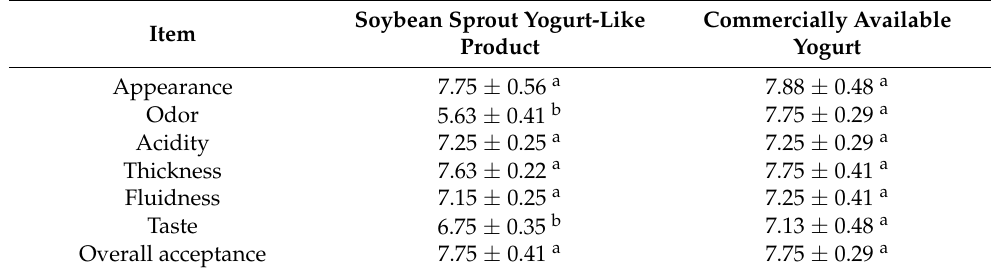
Table 5. Sensory characteristics of fermented yogurts (means ± SD for n = 3). a and b in the table represent two product were significant difference in various sensory evaluation